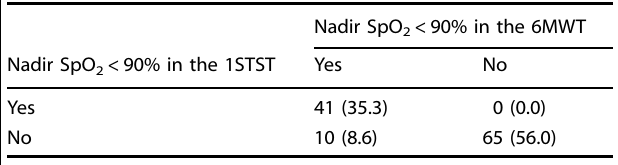
Fig. 2 Bland-Altman plot of the difference in SpO 2 nadir between the 1STST and 6MWT as a function of the mean SpO 2 nadir in the two tests. The mean difference (solid line) and the limits of the 95% con fi dence interval (dotted lines) are presented. 1STST 1 min sit-to- stand test, 6MWT 6 min walk test, SpO 2 pulse oxygen saturation. Table 2. Oxygen desaturation during 1STST and